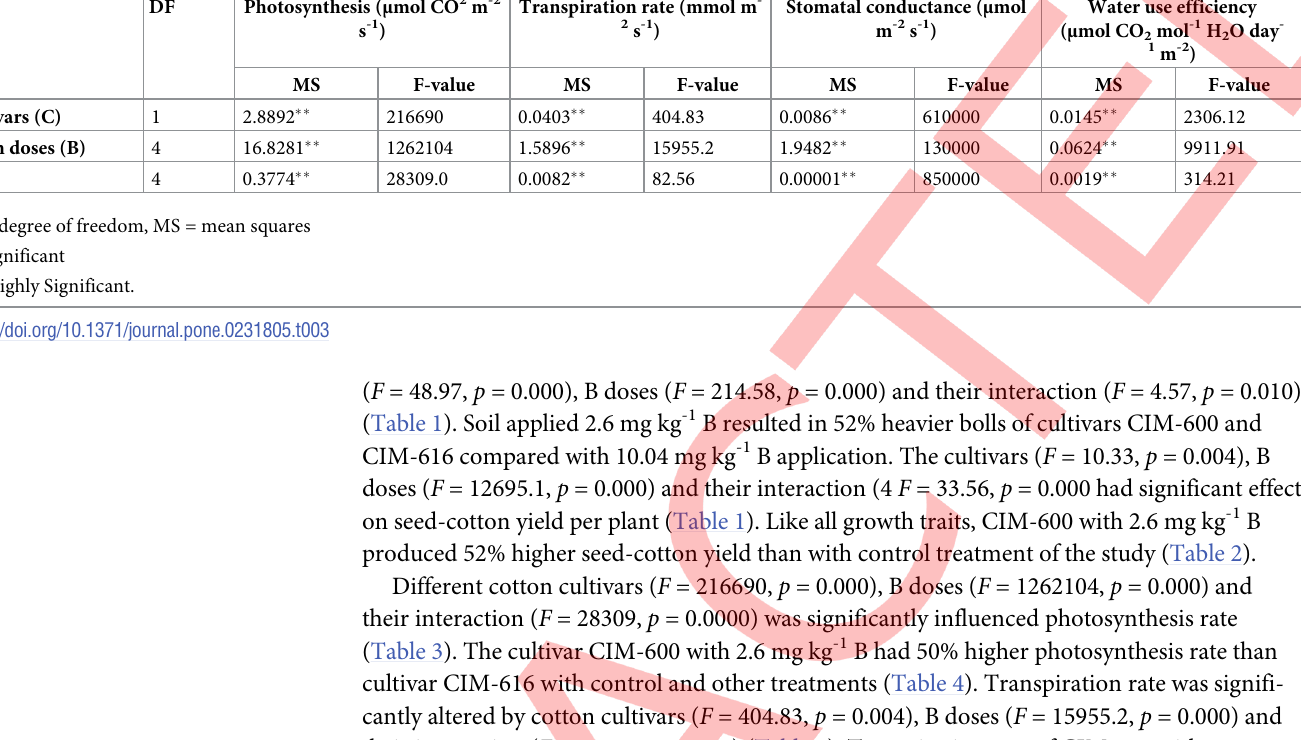
(Table 3). The cultivar CIM-600 with 2.6 mg kg -1 B had 50% higher photosynthesis rate than cultivar CIM-616 with control and other treatments (Table 4). Transpiration rate was signifi- cantly altered by cotton cultivars ( F = 404.83, p = 0.004), B doses ( F = 15955.2, p = 0.000) and their interaction ( F = 82.56, p = 0.000) (Table 3). Transpiration rate of CIM-600 with 2.6 mg kg -1 B was 10% higher than CIM-616 with control and other treatments. The cultivars ( F = 6.1000, p = 0.000), B doses ( F = 1.3000, p = 0.000) and their interaction ( F = 8.500, p = 0.000) had significant impact on stomatal conductance (Table 3). Both tested cultivars had 37% higher stomatal conductance with 2.6 mg kg -1 B compared with the control treatment (Table 4). Water use efficiency was significantly influenced by cultivars ( F = 2306.12, (Table 3). The cultivar CIM-600 with 2.6 mg kg -1 B had 44% higher water use efficiency than CIM-616 with no B application (Table 4).